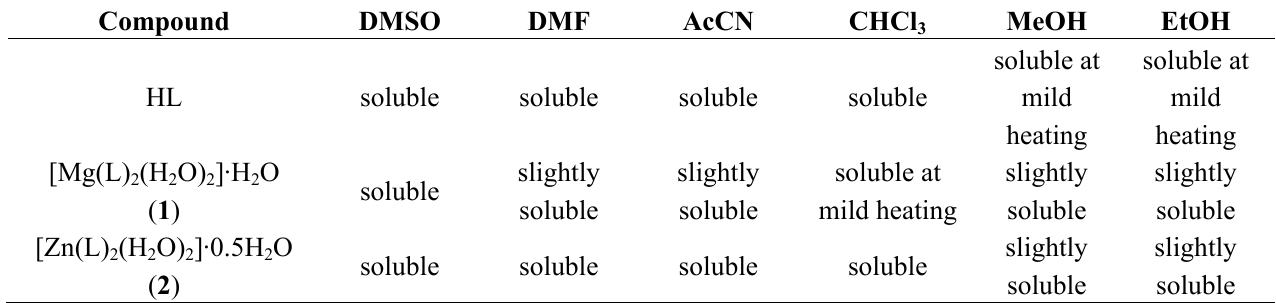
Table 1. Solubility in different solvents of the parent ligand and its complexes.